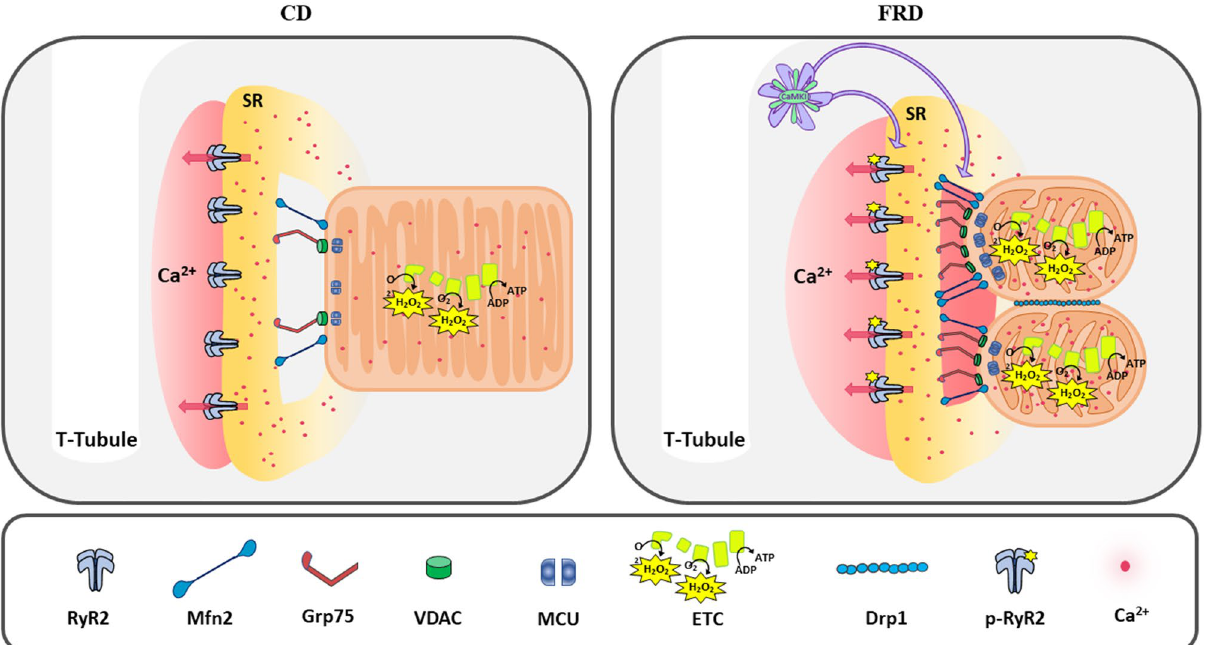
Figure 10. Conclusion and discussion cartoon. Scheme representing the CaMKII pathway of mitochondria alterations produced by prediabetes (right) with respect to normal CD (left). CaMKII, Ca 2+ -Calmodulin kinase II. SR, sarcoplasmic reticulum. RyR2, ryanodine receptor 2. Grp75, glucose-regulated protein 75. Mfn2, Mitofusin 2. VDAC, voltage-dependent anion channel, MCU, mitochondrial Ca 2+ uniporter. Drp1, dynamin- regulated protein 1. ETC, electron transport